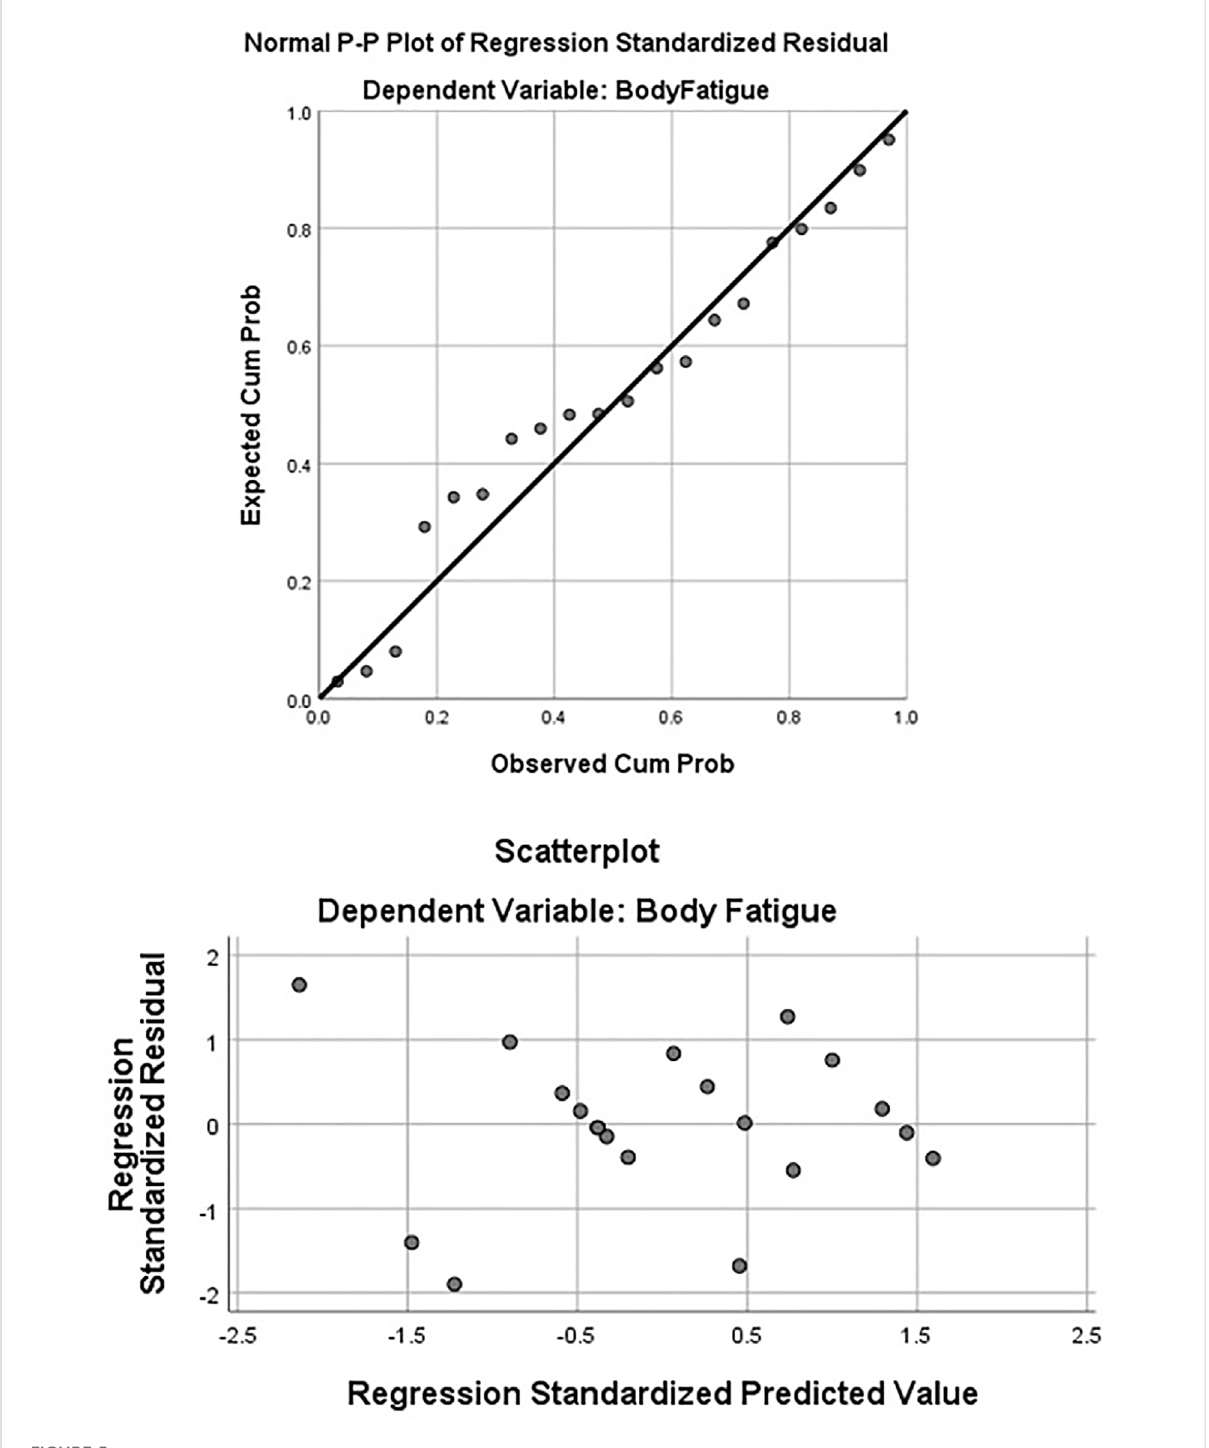
FIGURE 5 Diagnostic plots, body